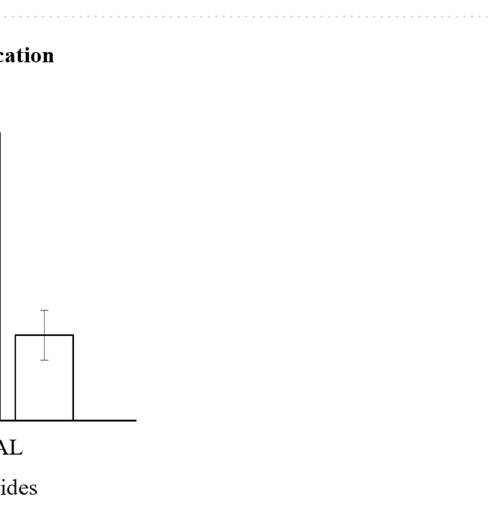
Figure 5. Proteolysis assay results. Electrophoresis on SDS-PAGE in 14% (w/v) acrylamide gels displaying the fragment bands of alginate lyase (ID 22) (0.83 g/L) after incubation with pancreatin (final concentration of 2.5 g/L). The gel band of 31.8 KDa corresponds to purified protein, whereas the other bands correspond to degraded protein and pancreatin. B: blank (purified undigested ID22) P: purified protein submitted to hydrolysis by pancreatin, M: protein marker.